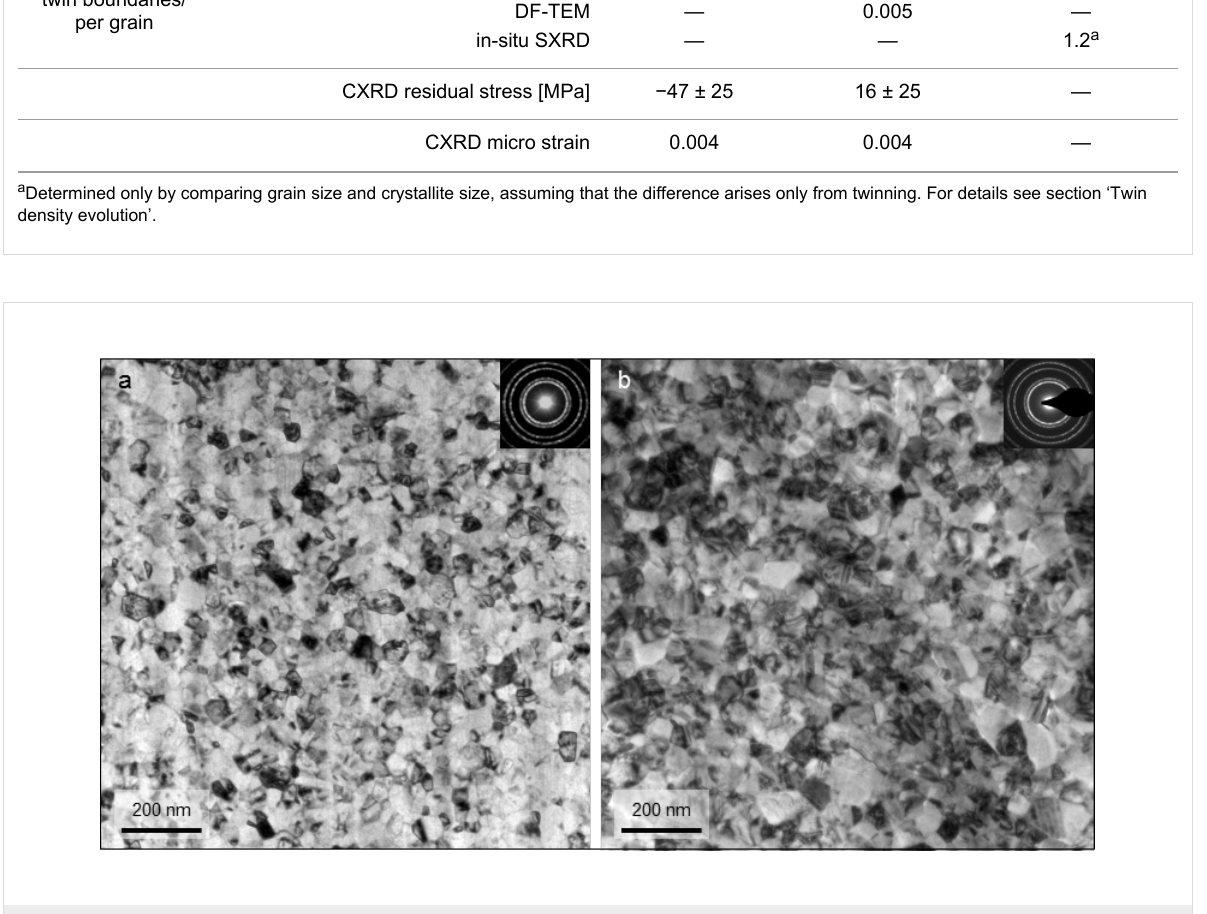
function of strain is given for all sample sets and analysis methods. Independent of sample set and method, an increase in in-plane crystallite size with increasing strain was observed, leading to an increase in crystallite diameter of ca. 45% at 10% strain for sample sets ncPd 1 and ncPd 2. This trend was also confirmed by in-situ SXRD and sample set ncPd 3. On the other hand, the CXRD crystallite size, representing the crystallite